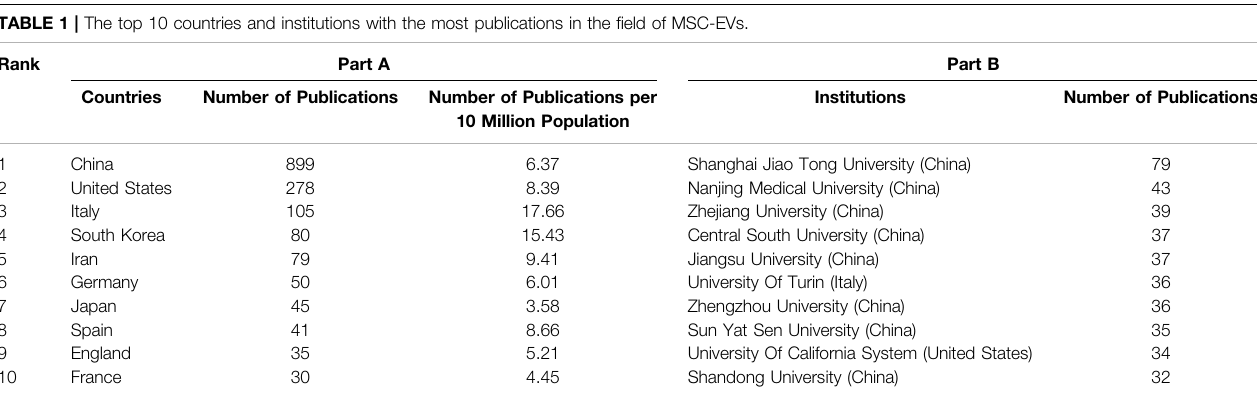
TABLE 1 | The top 10 countries and institutions with the most publications in the fi eld of MSC-EVs. Rank Part A Part B Countries Number of